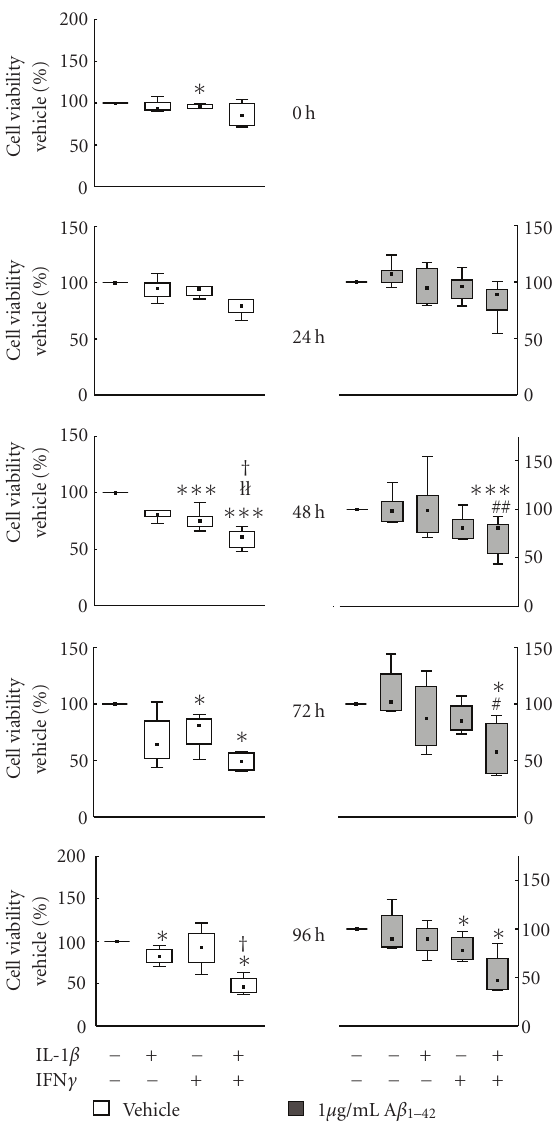
Figure 9: E ff ects of interleukin-1 β (IL-1 β ) and interferon- γ (IFN γ ) on cell viability in human CHME3 microglial cells treated with A β 1 – 42 (grey boxes) or vehicle (white boxes). The cells were preincubated with 50ng/mL IL-1 β and 50 ng/mL IFN γ for 24 hours prior to addition of A β 1 – 42 (1 μ g/mL). At 24, 48, 72, and 96 hours after addition of A β 1 – 42 the viability of the cultures was assessed with the MTT assay. The data are expressed as % of control (vehicle) set at 100% and shown as median ± percentiles (25%–75% and 10%–90%), n = 4 (24, 48 h), n = 6 (72, 96 h). Statistical di ff erence from vehicle is indicated by ∗ ( P < . 05) and ∗∗∗ ( P < . 005), and statistical di ff erence from A β 1 – 42 is indicated by # ( P < . 05) and ## ( P < . 01). łł ( P < . 01) indicates statistical di ff erence between IFN γ and IL-1 β +IFN γ , and † ( P < . 05) indicate di ff erences between IL-1 β and IL-1 β +IFN γ